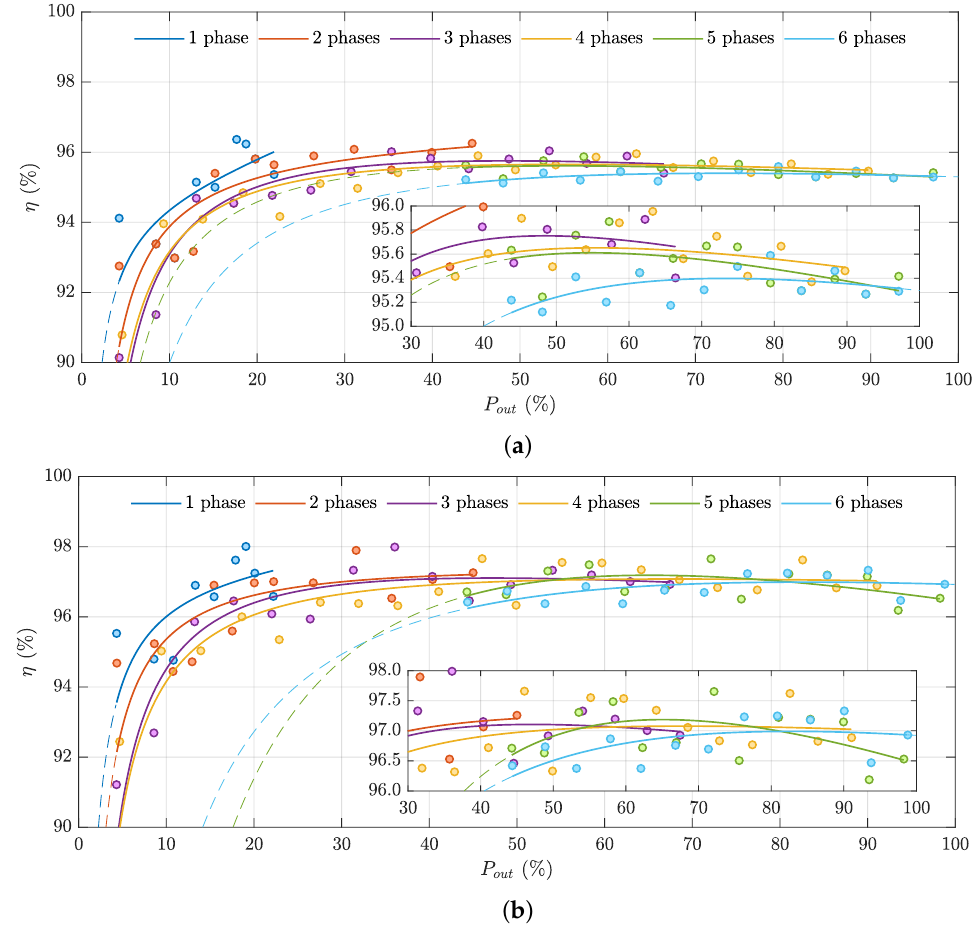
Figure 16. Converter efficiencyw with various numbers of phases operating versus power increase normalized to the rated power of 1.5 kW in non-synchronous ( a ) and synchronous ( b ) modes of operation. The experimental data are represented with colored circles, and the traces represent the interpolations of the